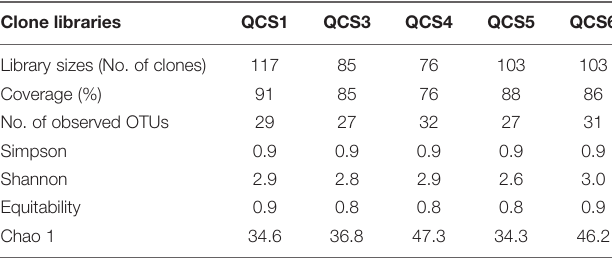
TABLE 2 | Ecological estimates and major group affiliation of clone sequences retrieved from the five cold springs on the Qinghai-Tibet